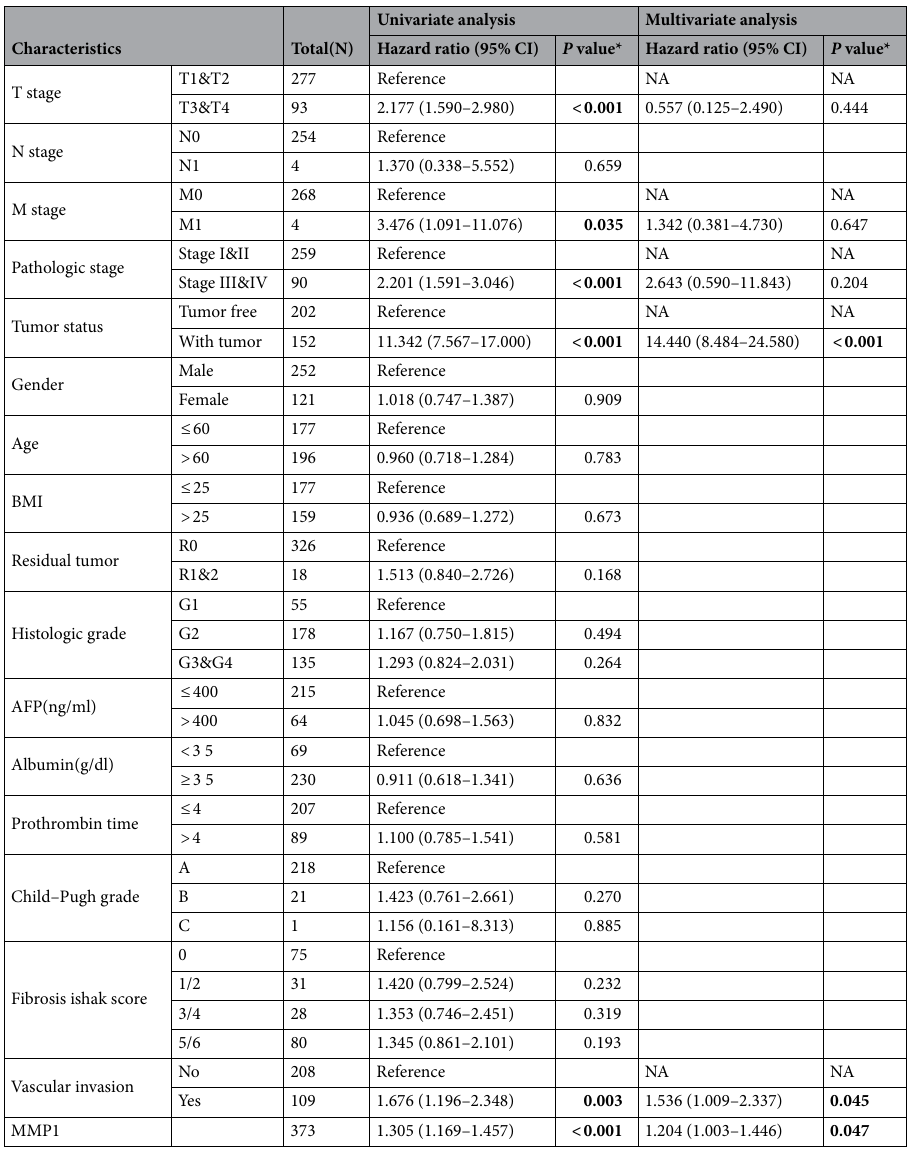
Table 6. The univariate and multivariate analysis for the PFI. PFI progress free interval, CI confidence interval, NA reference group or could not be evaluated. *Compared with each group (Log-Rank test or Omnibus test for univariate, Cox regression analysis with adjusted hazard for multivariate). p < 0.05 means statistically significant (highlighted in